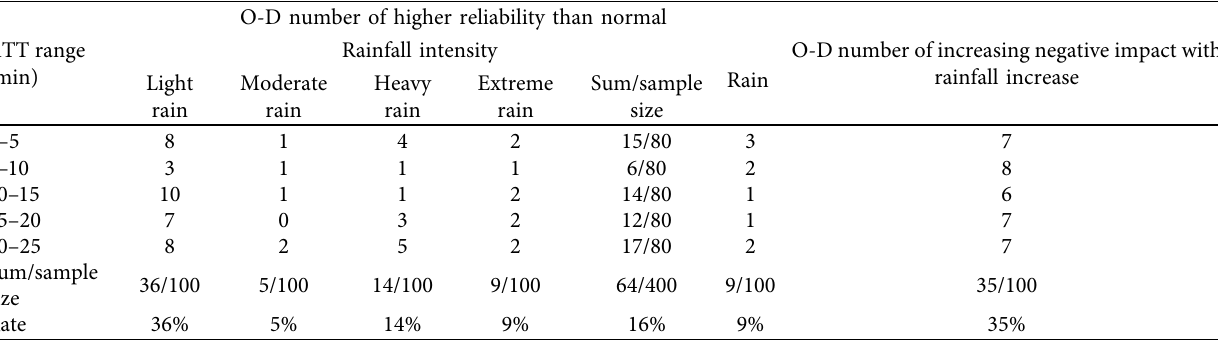
Table 5: Summary of O-D number of higher reliability than normal and increasing reduction impact with rainfall increase. ATT